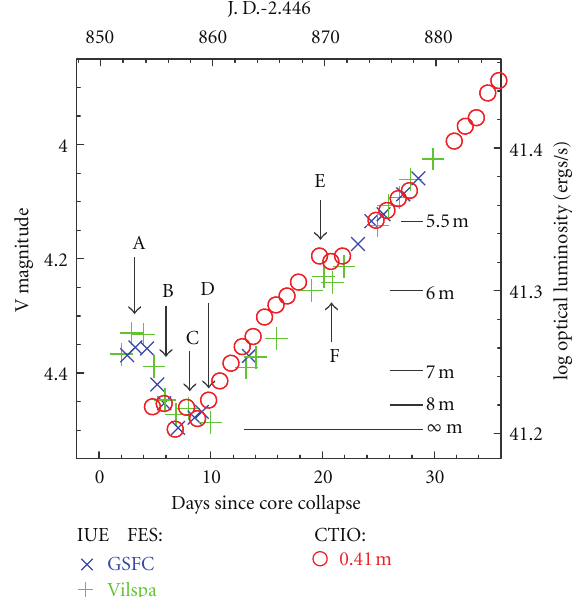
Figure 3: The very early luminosity history of SN 1987A as observed with the fine error sensor of IUE and the 0.41-m at CTIO. Data points taken at Goddard Space Flight Center by Sonneborn & Kirshner, and at the Villafranca Station in Madrid, are marked (see Section 2). The diameter of the circles representing the CTIO data is about three times the error. A V magnitude scale, for excess light above the minimum near day 7, is given, within the frame, on the